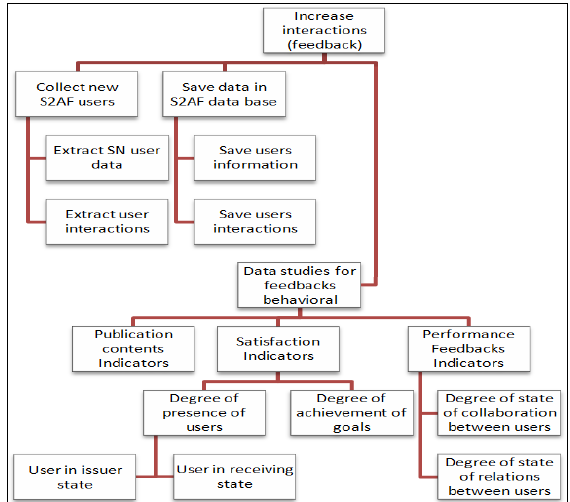
Figure.9. Hierarchical diagram of S2AF Goals